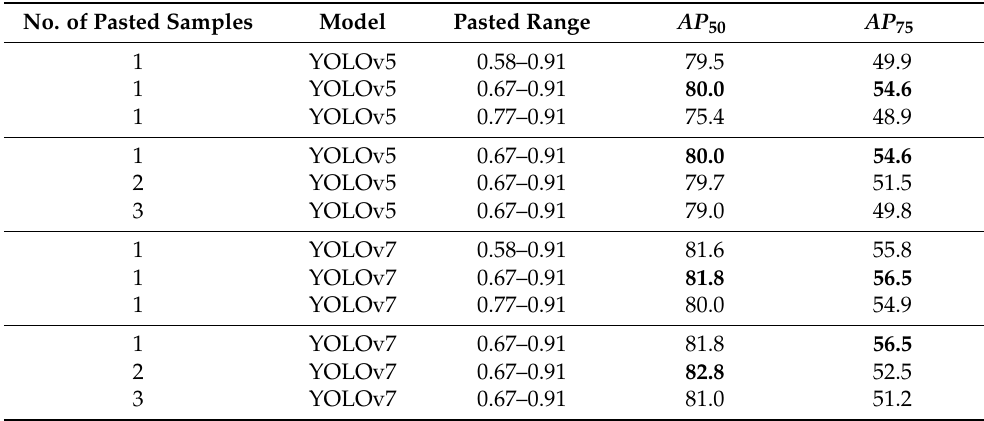
metrics were adopted from